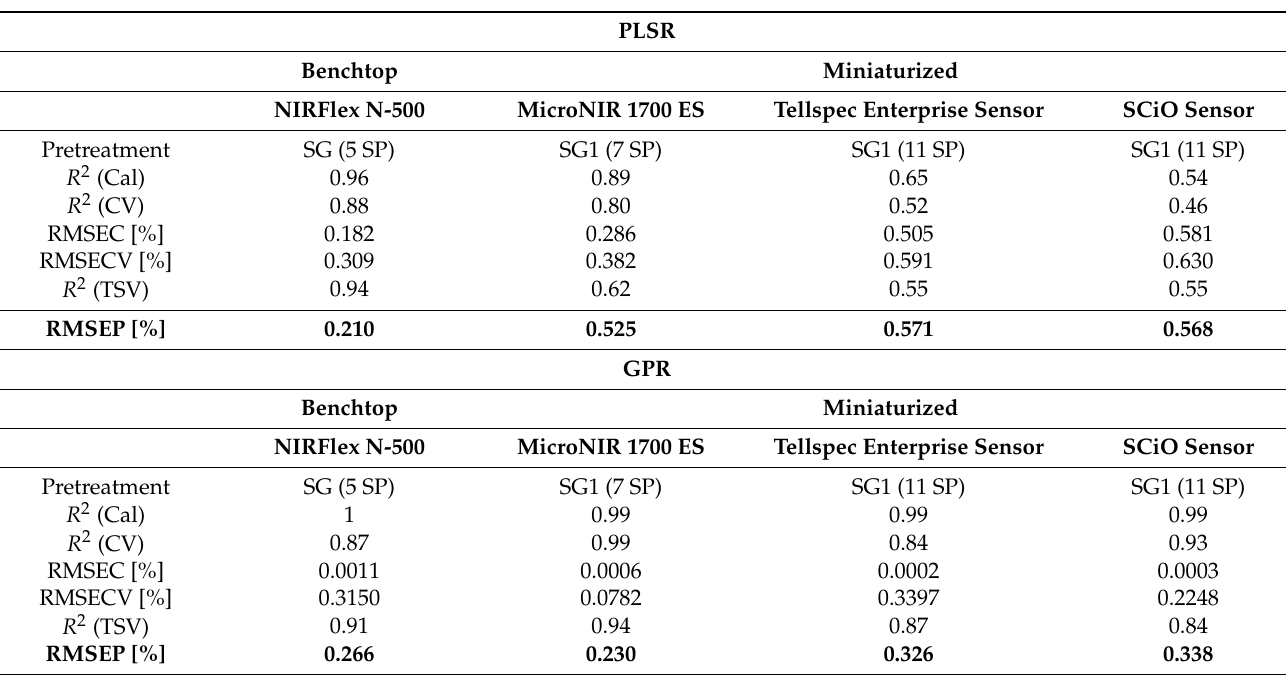
Table 3. The parameters of the best performing regression models for the analysis of protein content (range: 19.3–23.0% ( w / w )) in milled